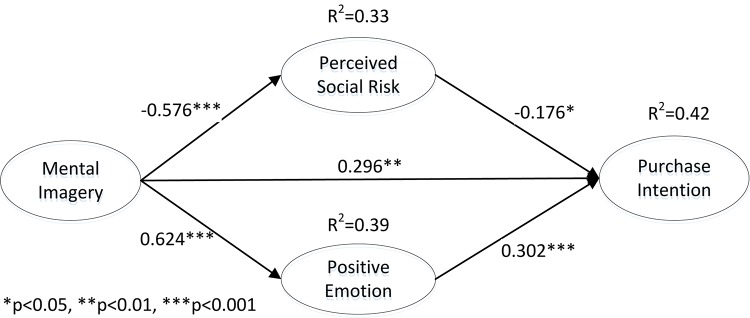
Results for the structural model (full sample).